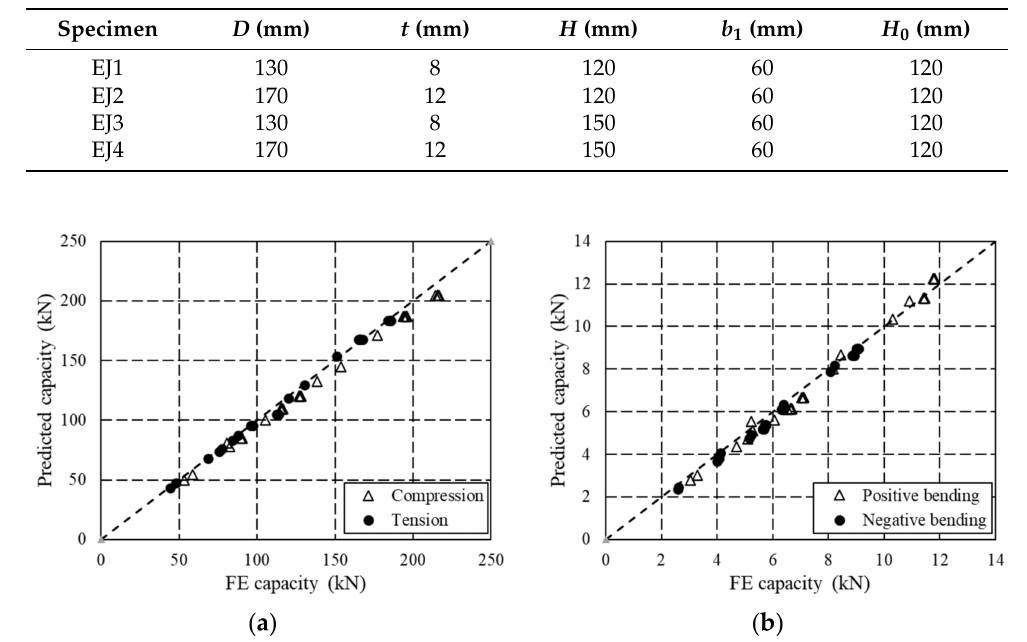
Table 3. Verification of the proposed design method.